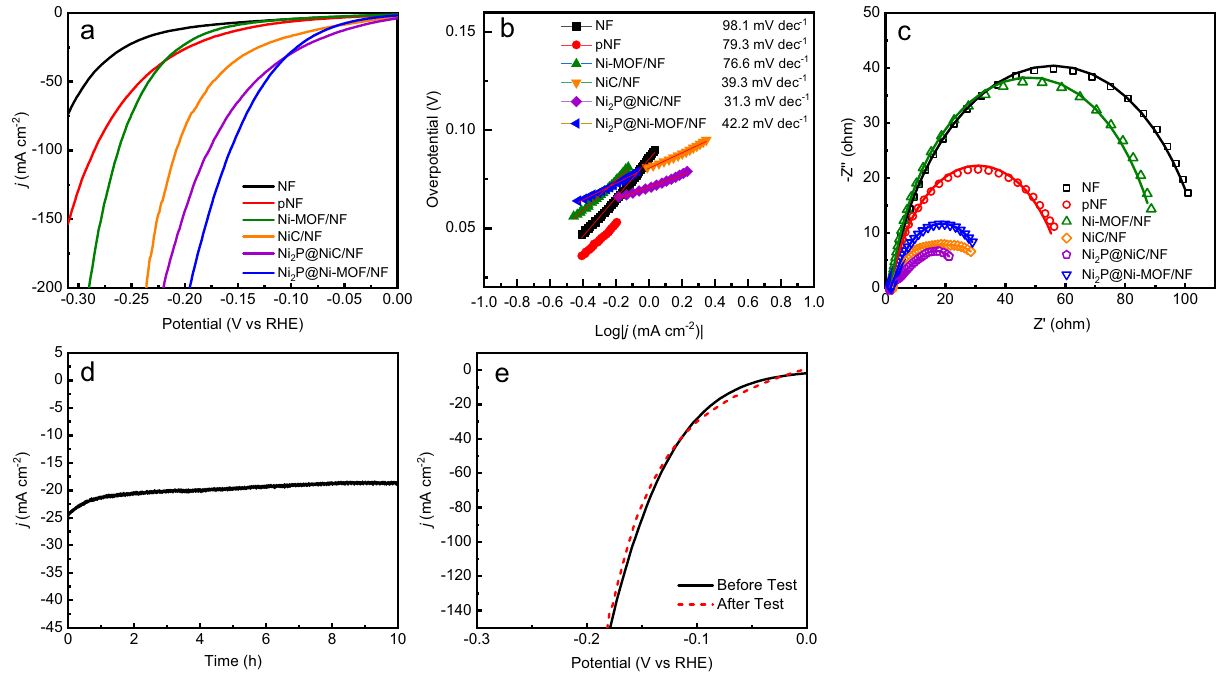
Figure 7. ( a ) LSV curves, ( b ) the corresponding Tafel plots and ( c ) the Nyquist plots of Ni 2 P@Ni-MOF/NF, Ni 2 P@NiC/NF, NiC/NF, Ni-MOF/NF, pNF and NF, ( d ) Chronoamperometric (i-t) curve of Ni 2 P@Ni-MOF/NF for 10 h. ( e ) LSV curves of Ni 2 P@Ni-MOF/NF before and after durability test. The electrolyte was 1.0 M NaOH with 0.33 M